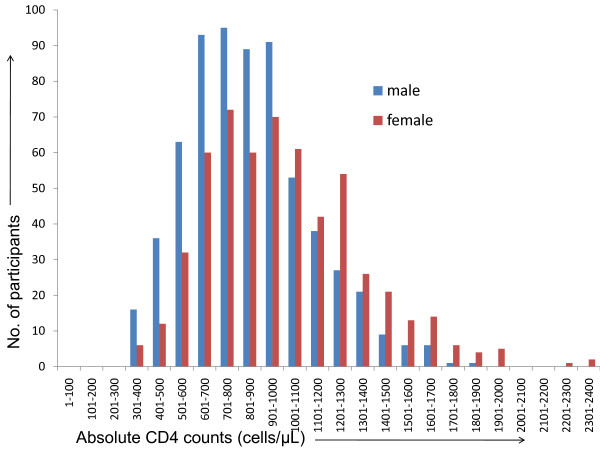
The figure showed the frequency distribution of absolute CD4 counts in healthy Indian adults. The × axis shows the absolute CD4 counts and the Y axis shows the number of participants. The blue and red bar represents the number of male and female participants respectively.